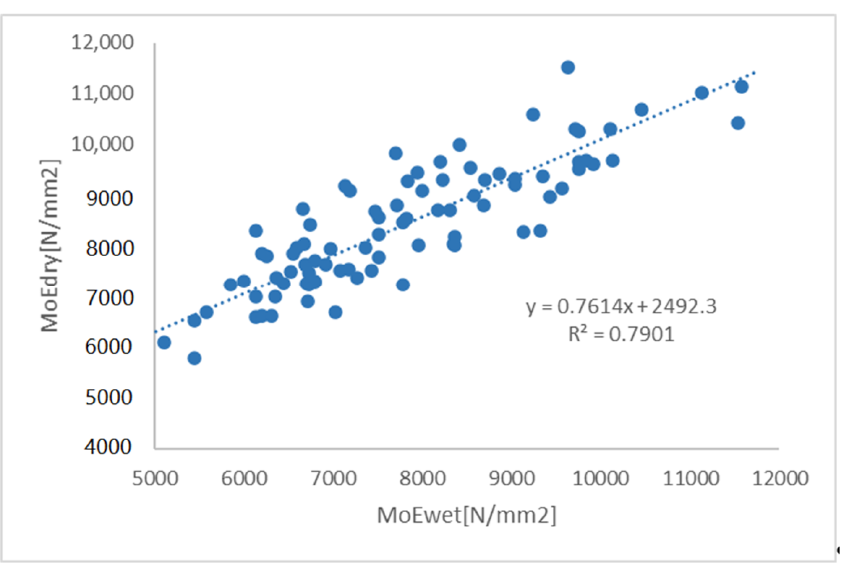
Figure 12. MoE wet vs. MoE dry .